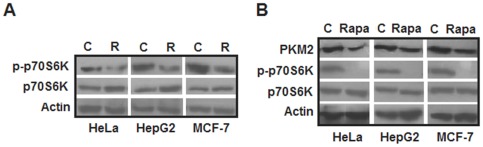
Western blots showing the effect of resveratrol on mTOR signaling and rapamycin (mTOR inhibitor) on PKM2 expression.Resveratrol (50 µM) inhibited mTOR signaling in all the three cell lines studied as evident from decreased phosphorylation of p-p70S6K upon resveratrol treatment (A); C- Mock treated control and R- resveratrol treated. mTOR inhibition by 20 nM rapamycin reduced PKM2 expression in all experimental cell lines (B); C- Mock treated control and Rapa- 20 nM Rapamycin.